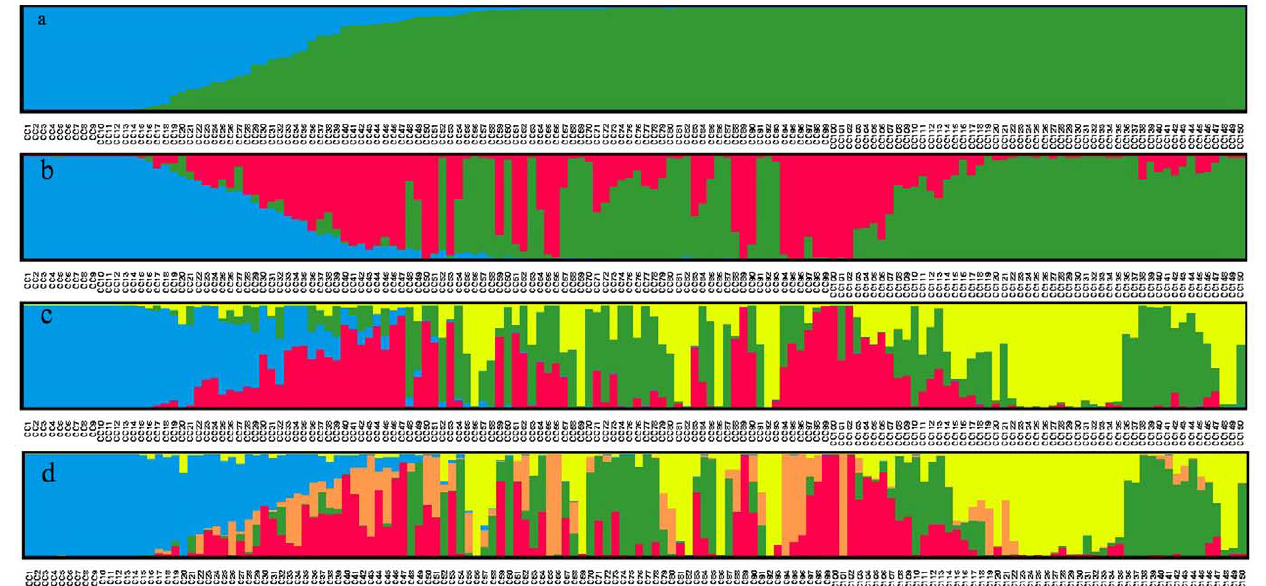
Figure 1. Membership probability of assigning genotypes of the entire population to ( a ) two, ( b ) three, ( c ) four, ( d ) five subgroups. The height of each bar represents the probability of varieties belonging to different subgroups. The varieties were sorted according to their